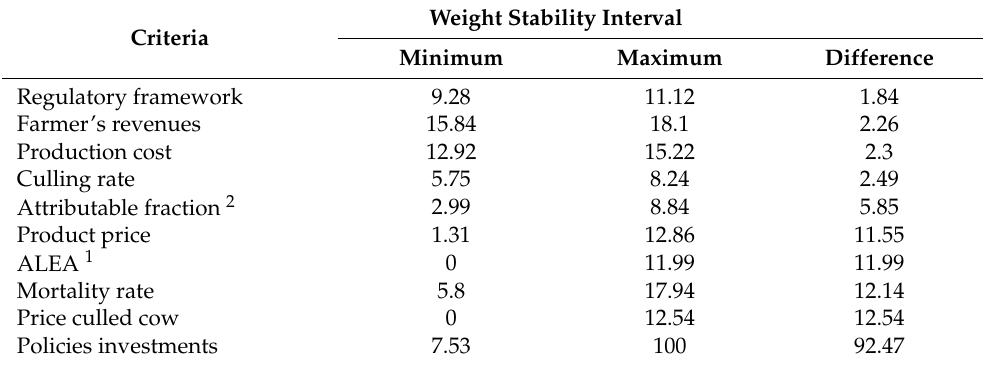
Figure 3. Performance profile of strategies to reduce antimicrobial use under each criterion. The strategies included were baseline strategy of antimicrobial use ( A ), total interdiction of antimicro- bial use ( B ), subsides to reduce antimicrobial use by 25% ( C ), and interdiction of preventive and metaphylactic antimicrobial use ( D ). Abbreviations. Economic dimension (blue): Production costs (PC), farmers’ revenues (FR), culled cow price (CP), milk price (MP). Environmental dimension (green): animal exposure level to antimicrobials (ALEA), attributable factor of antimicrobial-resistant human infection to livestock (AF). Social dimension (red): culling rate (CR), death rate (DR). Political dimension (pink): regulatory framework (RF), investment policies (IP). Table 2. Sensitivity analysis of stakeholder